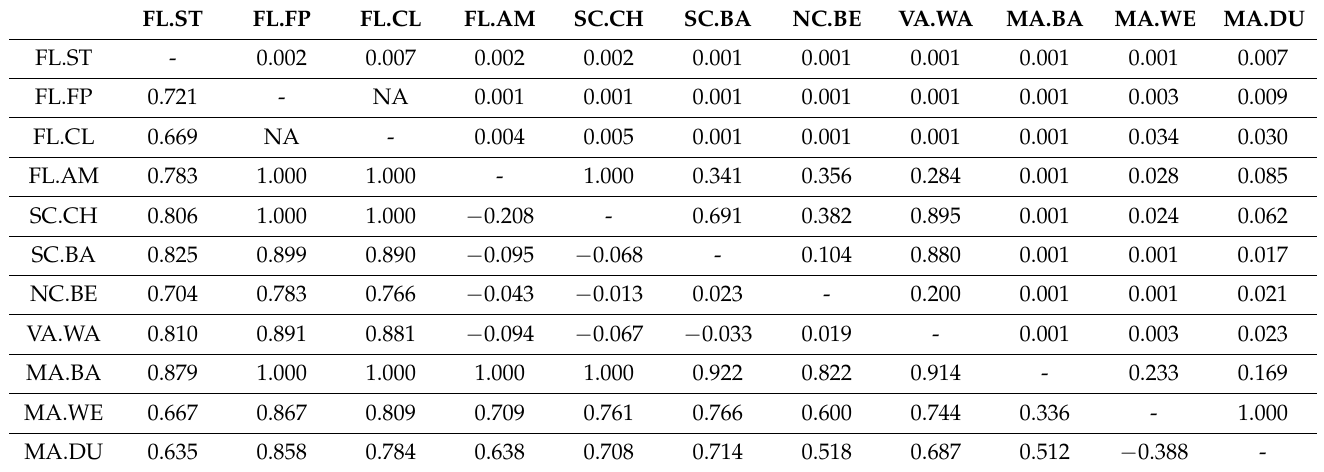
Table 5. Pairwise PhiST (below diagonal) and p -values (above diagonal) among regions.